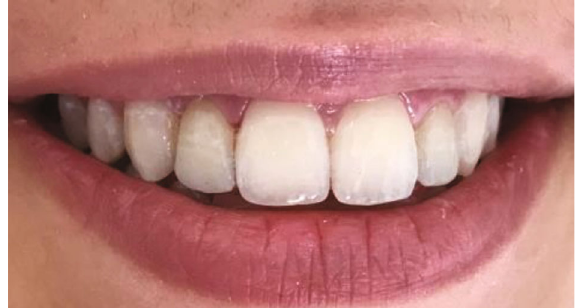
Figure 9: Final esthetic result which shows the natural aspect of the